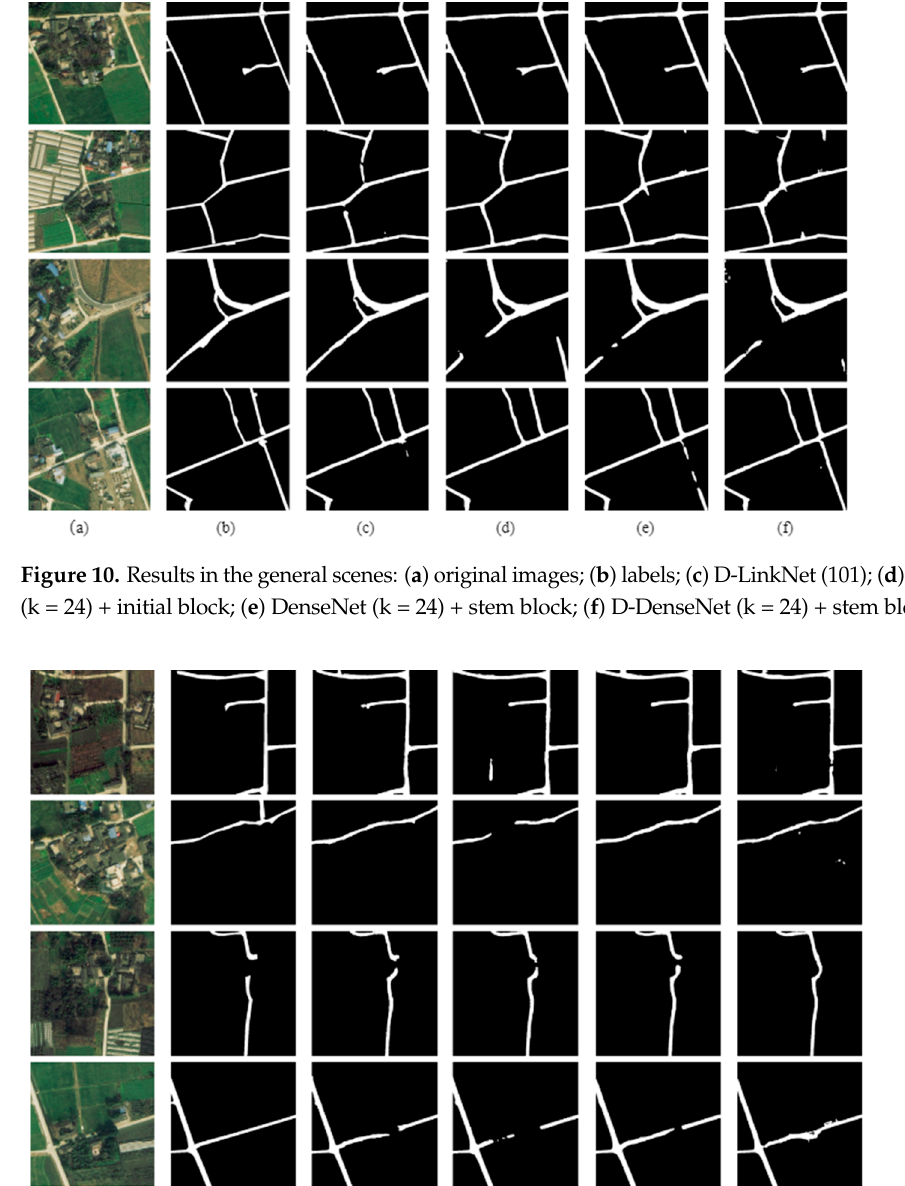
8 of 13 Figure 9. Results in the simple scenes: ( a ) original images; ( b ) labels; ( c ) D-LinkNet (101); ( d ) DenseNet (k = 24) + initial block; ( e ) DenseNet (k = 24) + stemblock; ( f ) D-DenseNet (k = 24) + stem block. All networks selected in this research have effective performance for road extraction in the simple scenes. The road areas are extracted precisely and almost closed to the labels. We selected four networks to extract roads from satellite images. In the experiment, the number of layers for D-LinkNet is 101, while, for other networks, the number of layers is set as 24. In the simple scenes, the difference is not obvious. For Figure 10, all networks did not recognize the highlighted greenhouses or highlighted buildings as road areas.